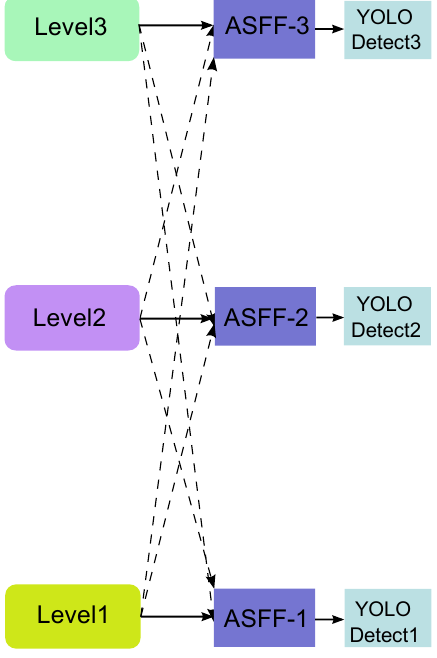
Figure 10. Structure of ASFF.